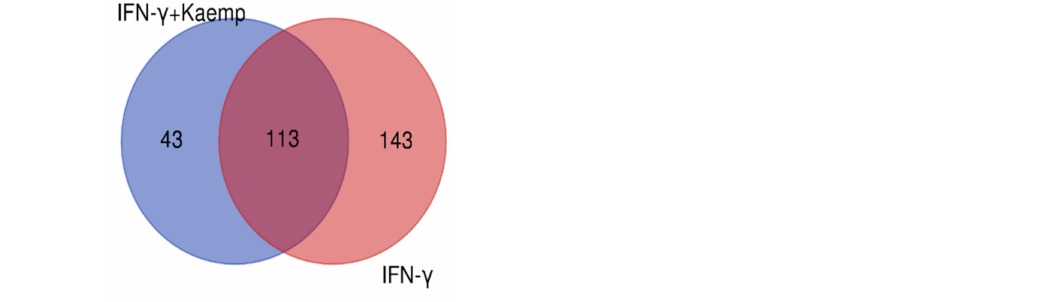
Figure 4. A Venn diagram comparing differentially expressed genes in both groups is shown. Venny